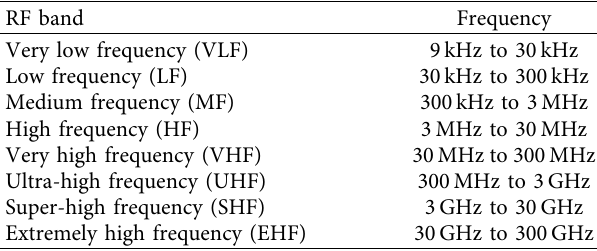
Table 1: Radio frequency